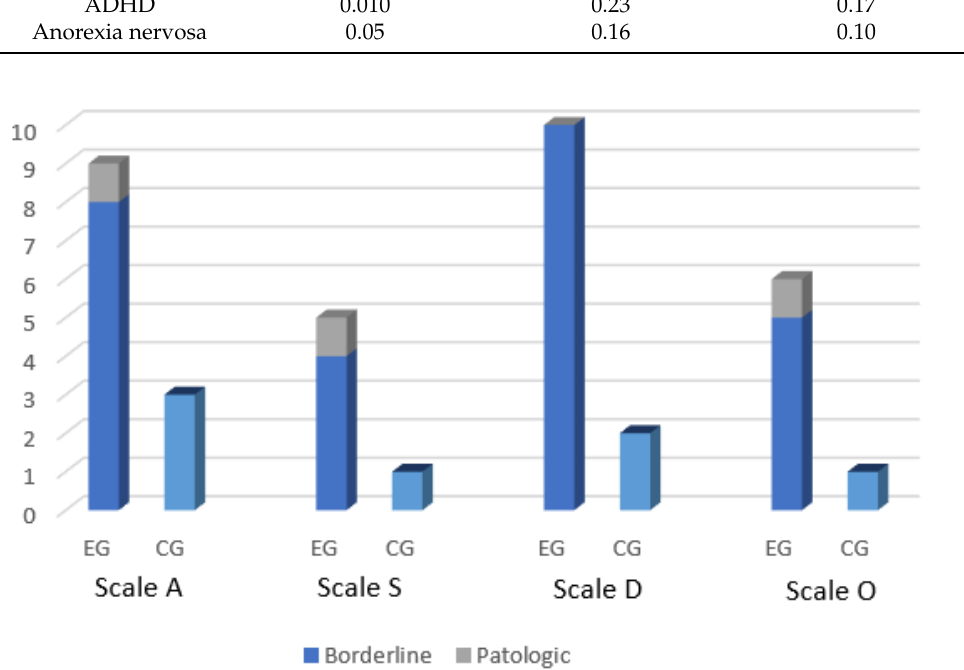
Table 3. Age-and sex-adjusted analyses of CABI domains between EG and CG. Domain